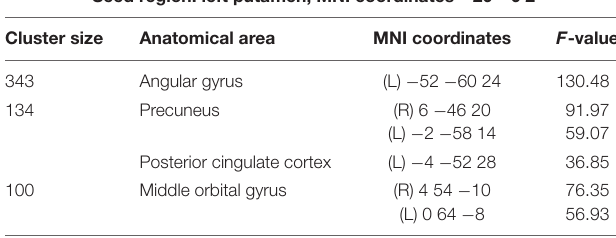
TABLE 4 | Age related significant decreases in connectivity [ p < 0.0055 (after Bonferroni correction), FWE corrected at cluster-level -voxel defining threshold p = 0.001].